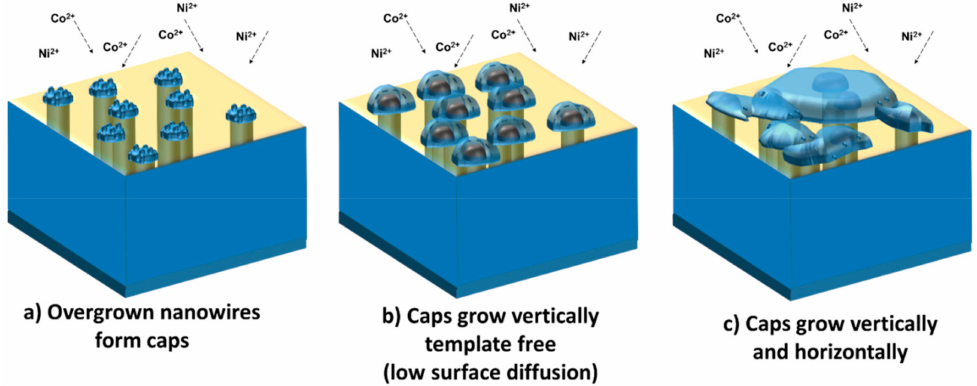
Figure 6. Illustration showing the growth of nanowire “mushroom” caps after the nanowires reach the surface. The membrane surface is illustrated here as a transparent area to better see the nanowires embedded in the